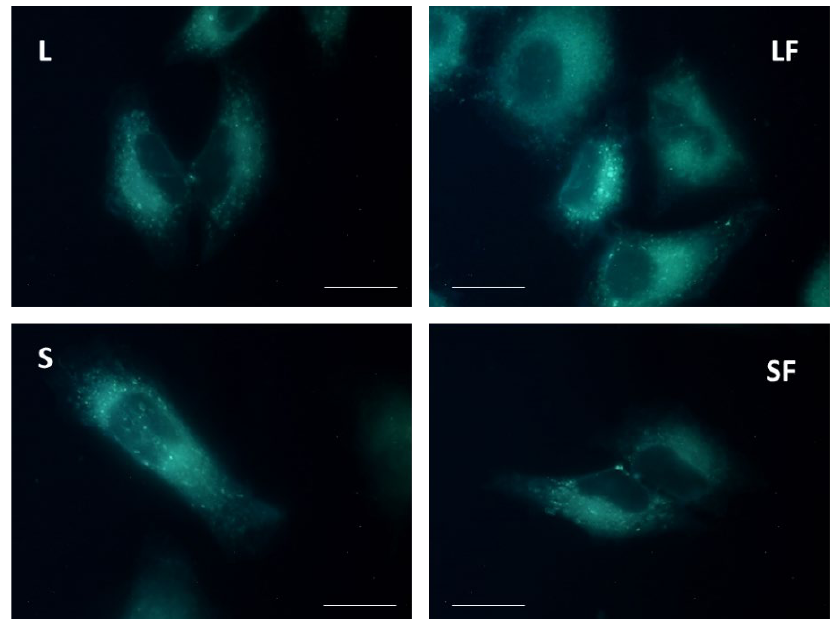
Figure 7. Fluorescent microscopy evaluation of BBR-loaded NPs uptake in T98G cells using Leica TCS SP8 confocal microscope at 63× magnifications (BBR exc. = 488 nm; emiss. = 500/600 nm). Scale bars = 10 µm. NPs with BBR LAU (L); NPs with BBR LAU and with folic acid coating (LF); NPs with BBR DS (S); and with folic acid coating (SF).